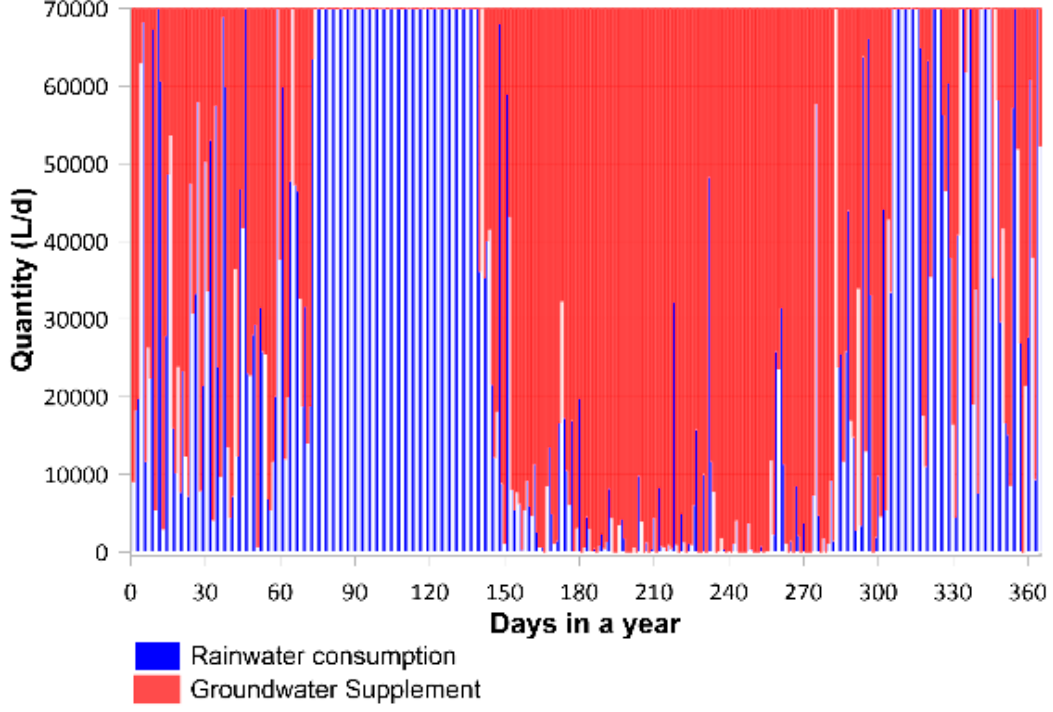
Figure 4. Daily rainwater consumption and required supplement to meet at demand of 70 L/person/d at NM ‐ AIST with a target maximum population of 1000 people.